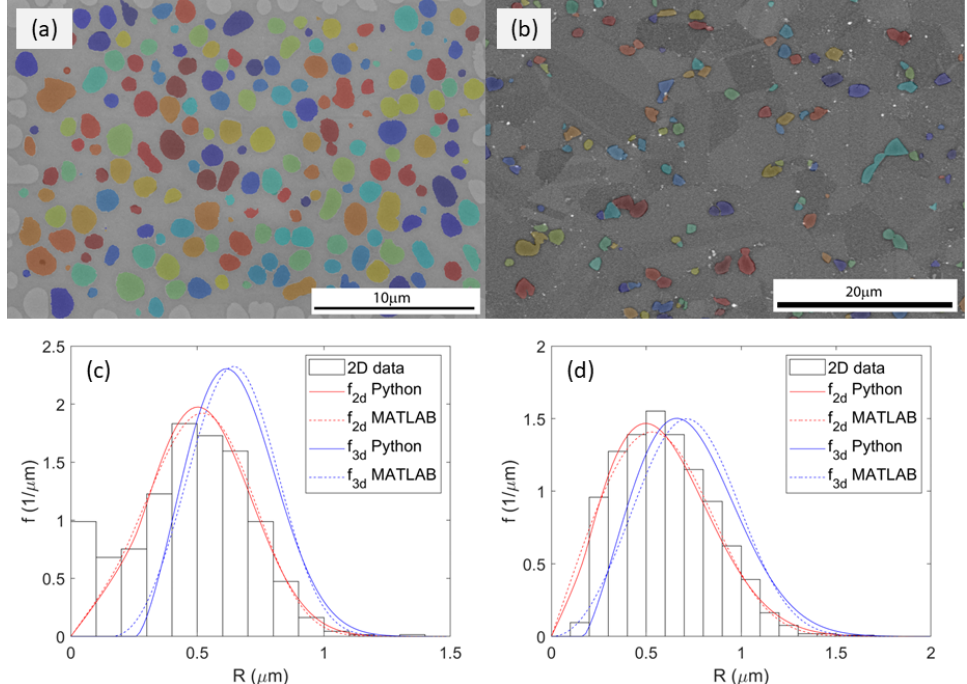
Figure 5. Example applications of the inverse analysis of the 3D size of the particle distribution, considering ( a ) the γ (cid:48) distribution in CC IN738LC aged at 900 ◦ C for 10,000 h. ( b ) The primary γ (cid:48) in air quenched fine grain RR1000. ( c , d ) present the measured distribution of particle cross-sections compared with the approximated 3D and 2D distributions obtained using the BFSG algorithm and simplex